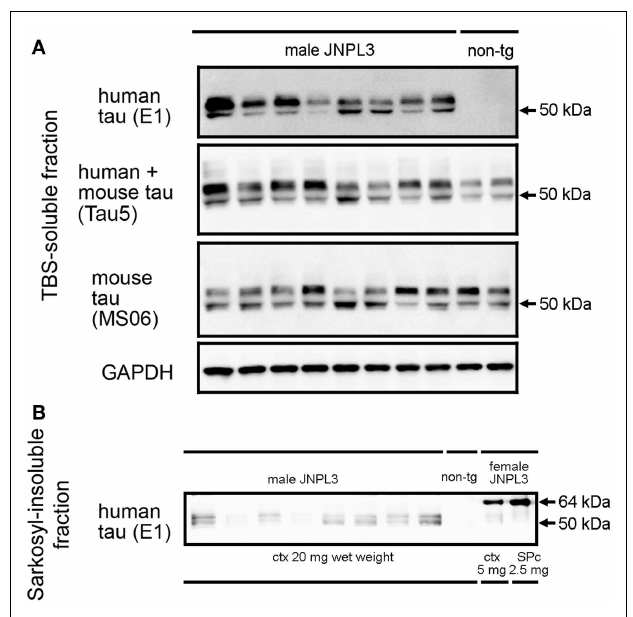
FIGURE 1 | Soluble and sarkosyl-insoluble tau in JNPL3 male mice . (A) Western blots ofTBS-soluble tau in mouse cerebral cortices. Equal volumes ofTBS-soluble fraction derived from 0.2mg wet weight of brain from eight male JNPL3 and two male non-tg mice were separated by SDS-PAGE, blotted, and then probed with E1,Tau5, MS06, and GAPDH antibodies. (B) Western blot of sarkosyl-insoluble fractions in mouse cerebral cortices. Samples derived from 20mg wet weight from male JNPL3 and non-tg mice, 5mg wet weight from female JNPL3 cortex (ctx), and 2.5mg wet weight from female JNPL3 spinal cord (SPc) were separated by SDS-PAGE, blotted, and then probed with E1 antibody.